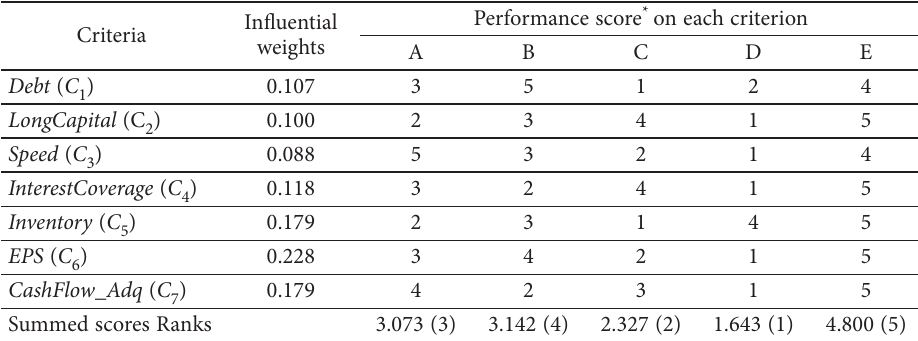
Table 9. The influential weights of DANP and the assumed performance scores of the five